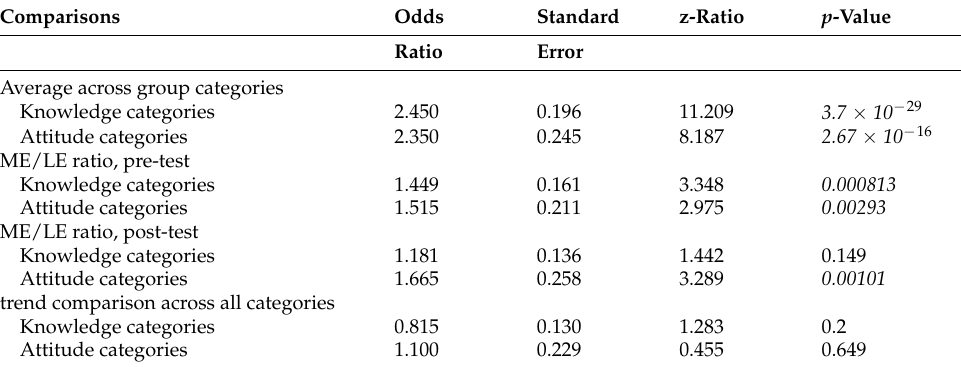
Figure 4. GLM’s estimates of percent correct scores for each category within the Knowledge group at each school separately, as well as averaged across categories overall and averaged across schools overall. Points show the estimated marginal means, colored by survey (before or after), and error bars show the 95% confidence intervals of the means. Table 2. Summaries of Pre/Post-Survey comparisons. Results are shown for categories in both Knowledge group (first row) and Attitude group (second row). An odds ratio of 1 indicates no change.